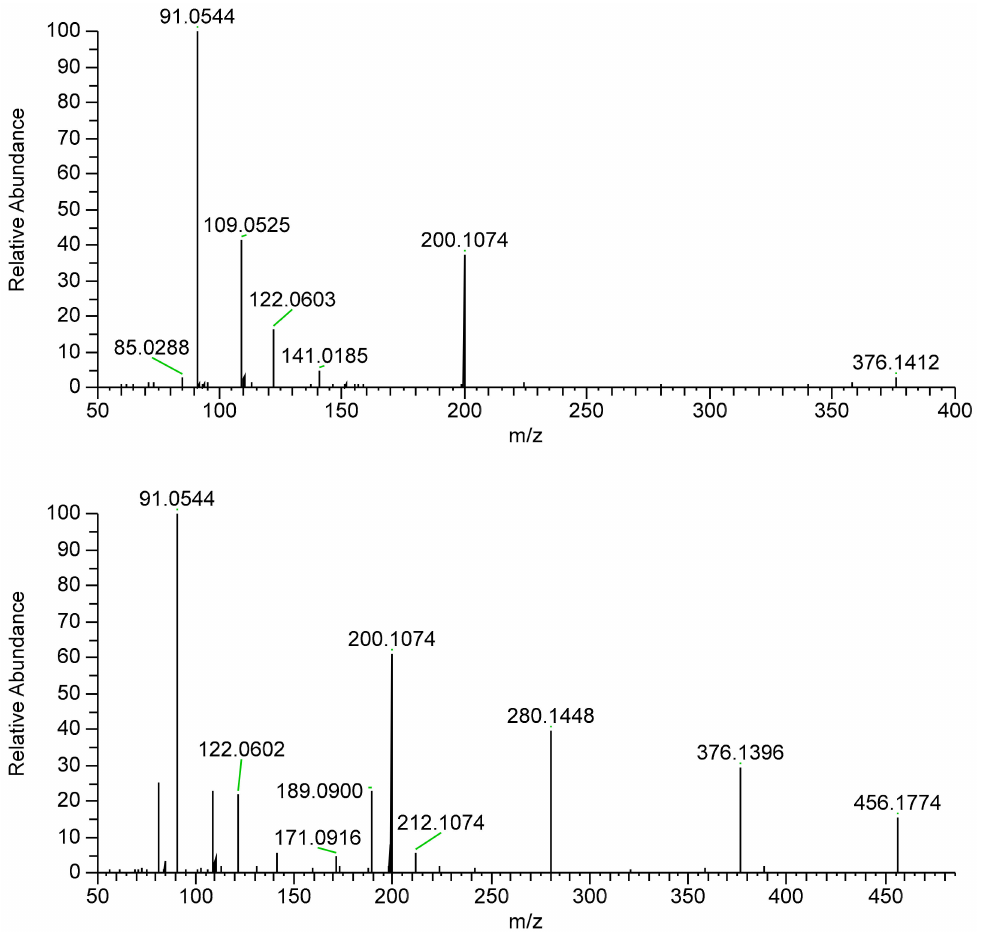
Figure A2. The MS2 spectra of the most prominent antazoline